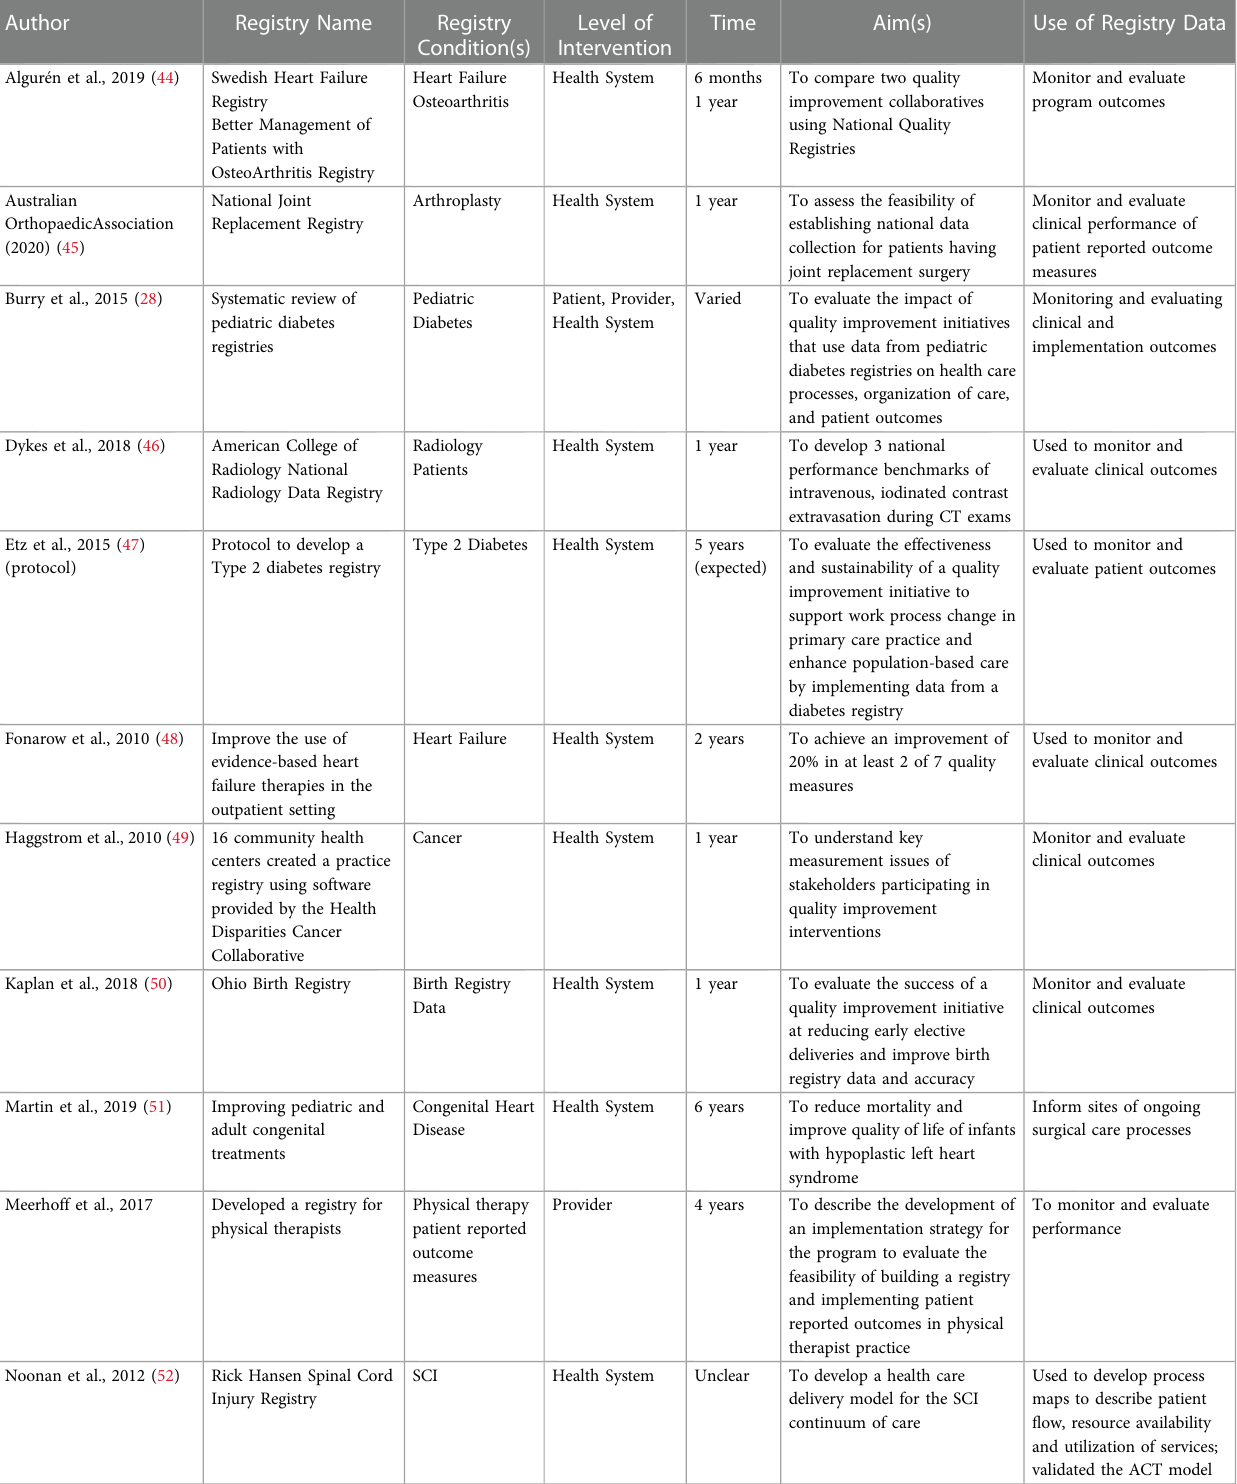
TABLE 1 Quality improvement approaches, level, timeline, aims, and use of registry